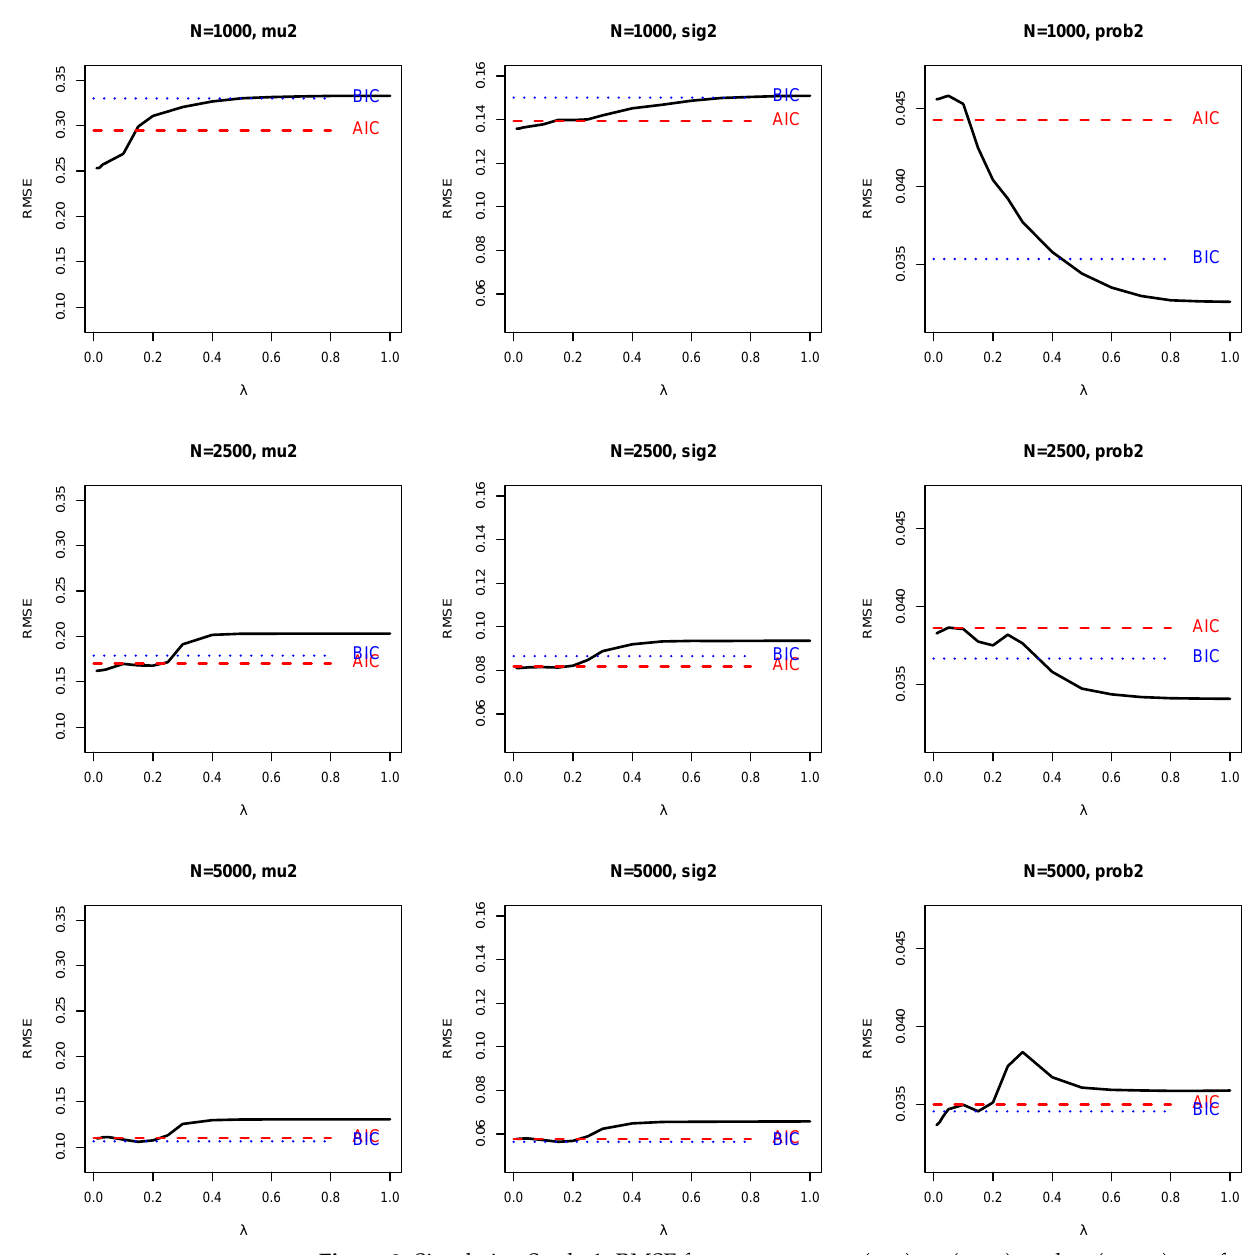
Figure 2. Simulation Study 1: RMSE for parameters µ 2 ( mu2 ), σ 2 ( sig2 ), and p 2 ( prob2 ) as a function of a fixed regularization parameter λ and optimal regularization parameters obtained from AIC or